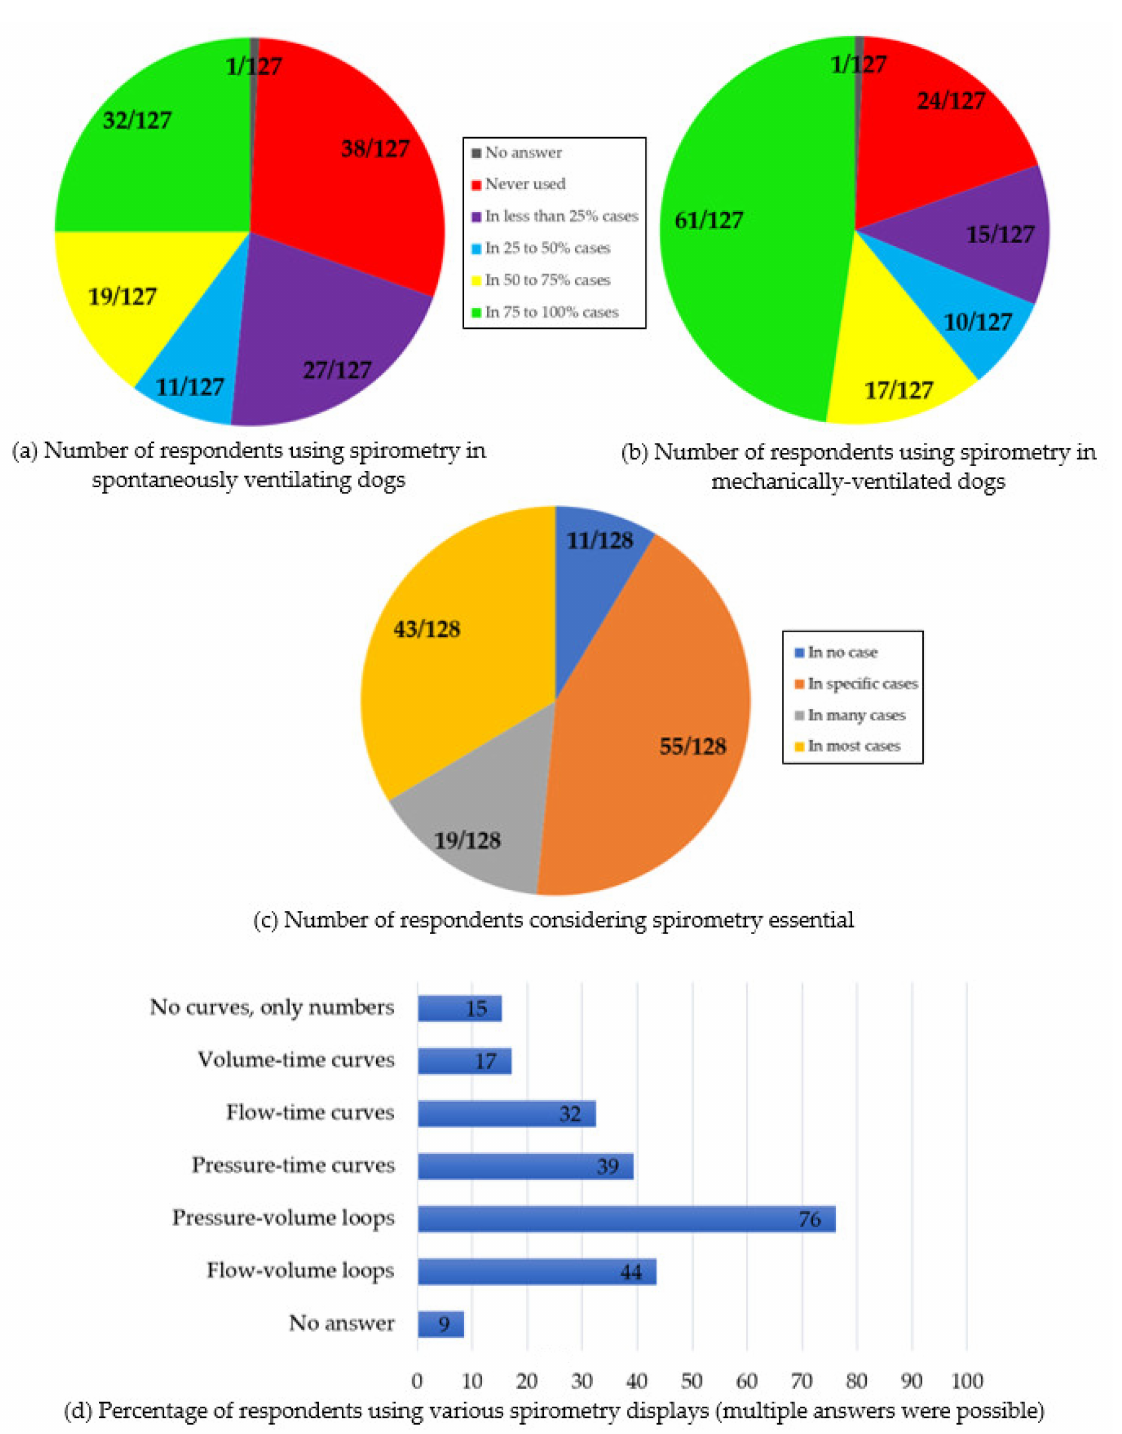
Figure 1. Summary of selected responses to an online survey on the use of spirometry in small animal anaesthesia and critical care by 128 respondents. ( a ) Number of respondents using spirometry in spontaneously ventilating dogs; ( b ) Number of respondents using spirometry in mechanically ventilated dogs; ( c ) Number of respondents considering spirometry essential; ( d ) Percentage of respondents using various spirometry